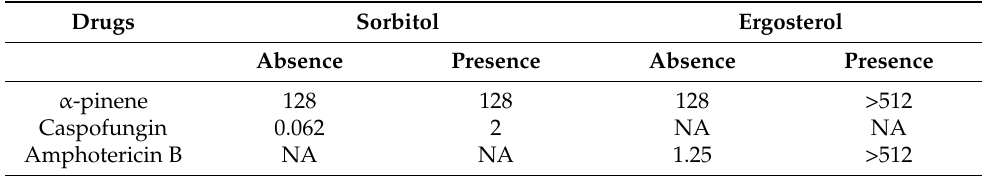
Table 2. MIC values ( µ g/mL) of drugs in the absence and presence of sorbitol (0.8M) and exogenous